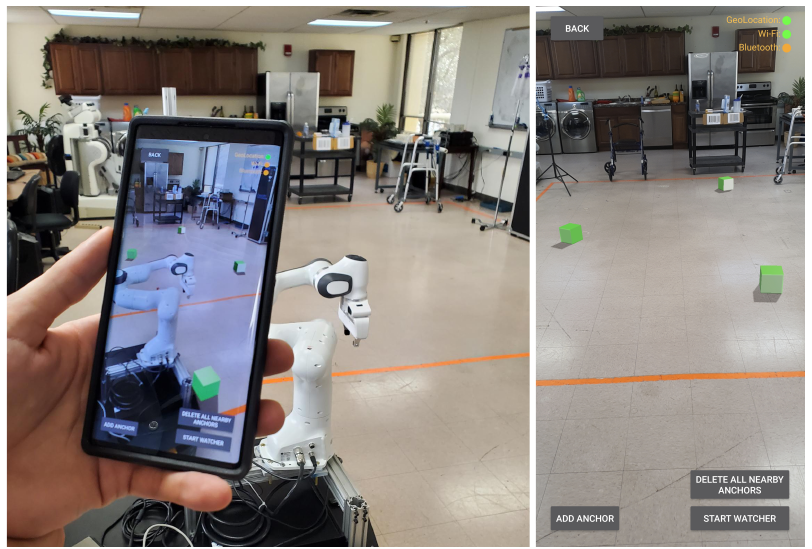
Figure 15. The ASAs used for robot navigation recreated on an Android device using ARCore. ( Left ) A view of the mobile app rendering points. ( Right ) A screen capture showing the default user